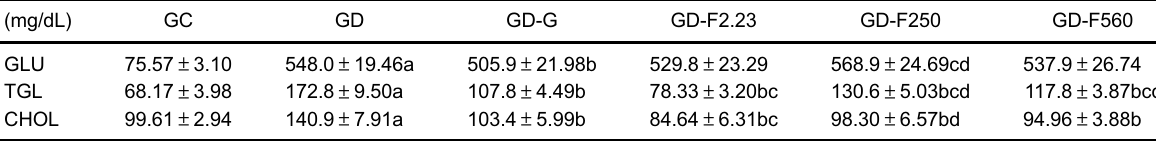
Table 3. Plasmatic pro fi le of mice from groups GC, GD, GD-G, GD-F2.23, GD-F250, and GD-F560.